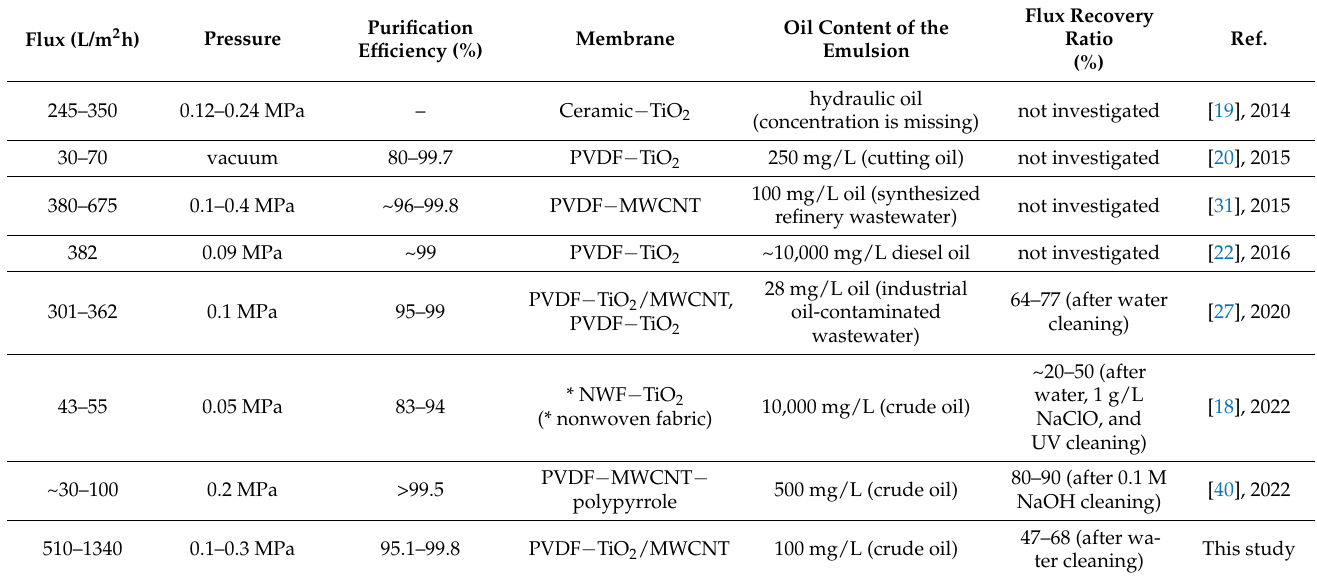
Table 1. Comparison of different TiO 2 - and/or CNT-modified membranes (used for the filtration of oil emulsions) with the current